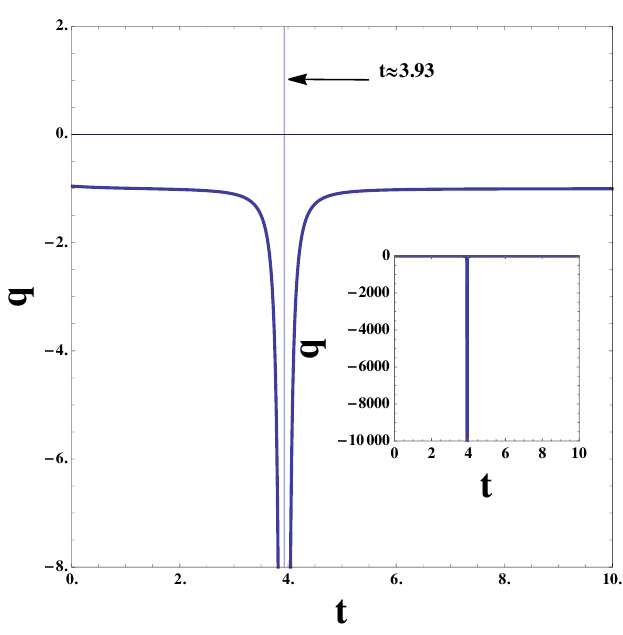
Figure 3. Evolution of the deceleration parameter q as a function of the cosmic time t